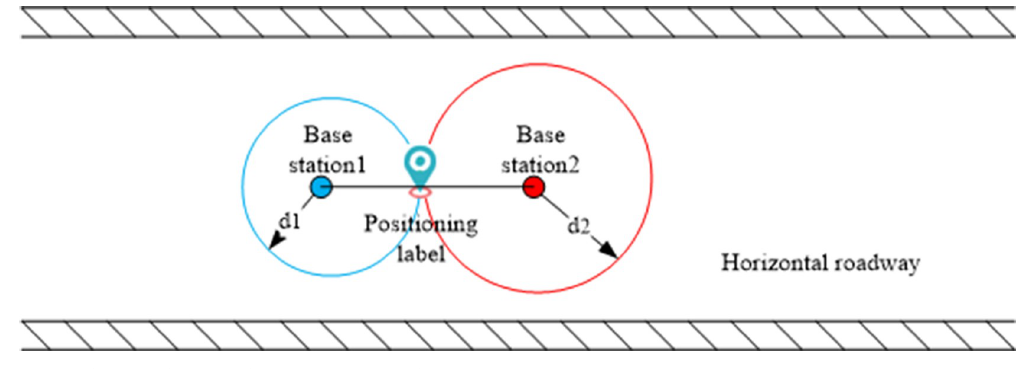
Fig 2. Schematic diagram of positioning